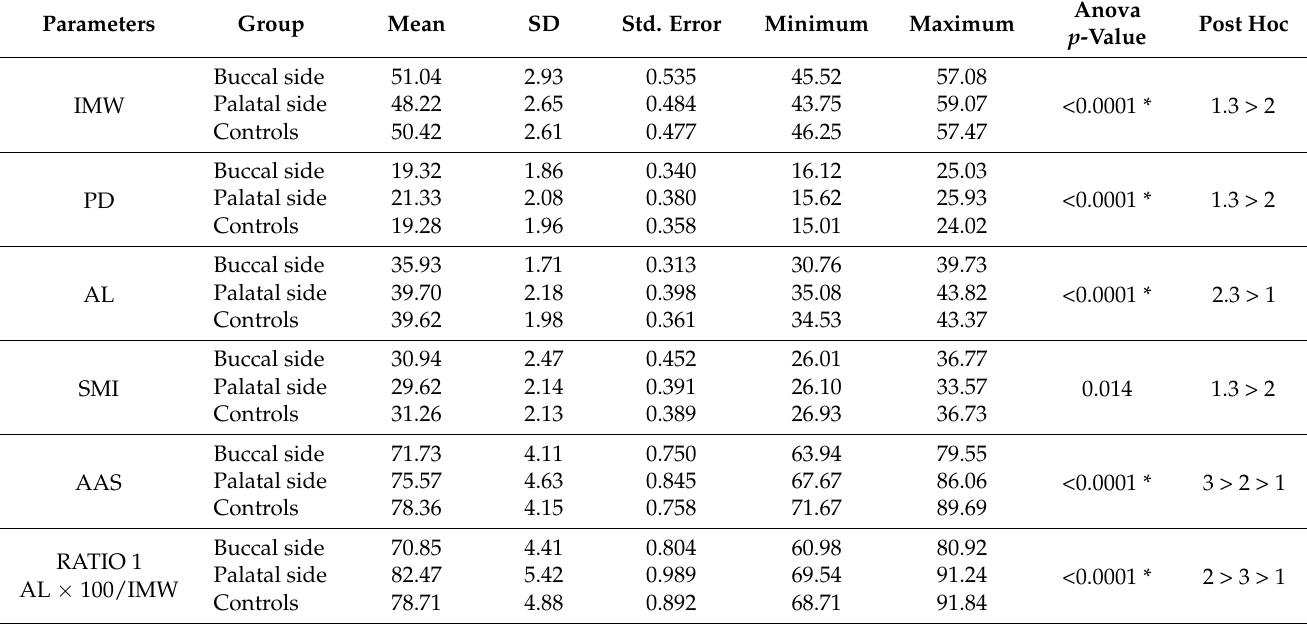
Table 3. Statistical comparison of maxillary arch measurements between the groups. The measure- ments recorded were IMW, Inter-molar width; PD, Palatal depth; AL, Arch Length; SMI, Sum of Maxillary Incisors; AAS, Available Arch Space and the Ratio 1,2, and